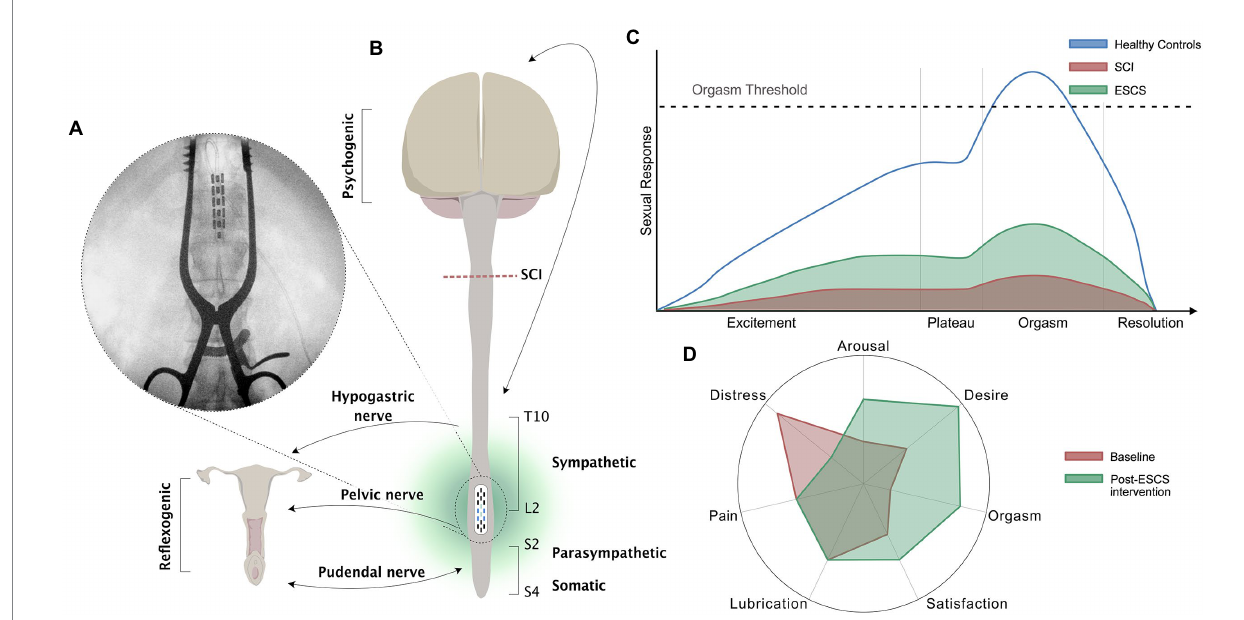
FIGURE 1 Schematic of the neural control of female sexual function, the female sexual response cycle, and the effects of SCS. (A) X-ray of the thoracolumbar spinal column of participant 02 with chronic T4, AIS A, SCI during implantation of ESCS. The epidural electrode was implanted at T11-T12 vertebral level; (B) Schematic diagram showing neural control of sexual responses in females with SCI above T10. Neurological pathways convey sexual responses in women through the pudendal nerve (S2-S4 somatosensory) innervating the clitoris and external labia, the pelvic nerve (S2-S4 parasympathetic) innervating the vagina and cervix, and the hypogastric nerve (T10-L2 sympathetic) innervating the cervix and uterus. Reflexogenic arousal refers to vaginal lubrication that occurs as a result of sensual touching and genital stimulation. Psychogenic arousal refers to vaginal lubrication that occurs as a result of arousal in the brain (e.g., through hearing, seeing, feeling, or fantasy); (C) The four-phase (excitement, plateau, orgasm, and resolution) linear model of the human sexual response adapted from Masters and Johnson (1966). The schematic presents the normal human sexual response (blue line) and the proposed depressed sexual response in women after SCI (red shading). The beneficial effect of ESCS on the four phases of the sexual response cycle in women with SCI is demonstrated by the green shading. Although criticized, this physiological response curve is based on 10,000 recordings of able-bodied participants, and gives us great insight into how physiological human sexual responses may be generated after SCI, allowing for possible therapeutic interventions; (D) A radial plot demonstrating the six domains of the Female Sexual Function Index, and sexual distress according to the Female Sexual Distress Scale, in three females from the E-STAND trial at baseline (red shading) and post ESCS intervention (green